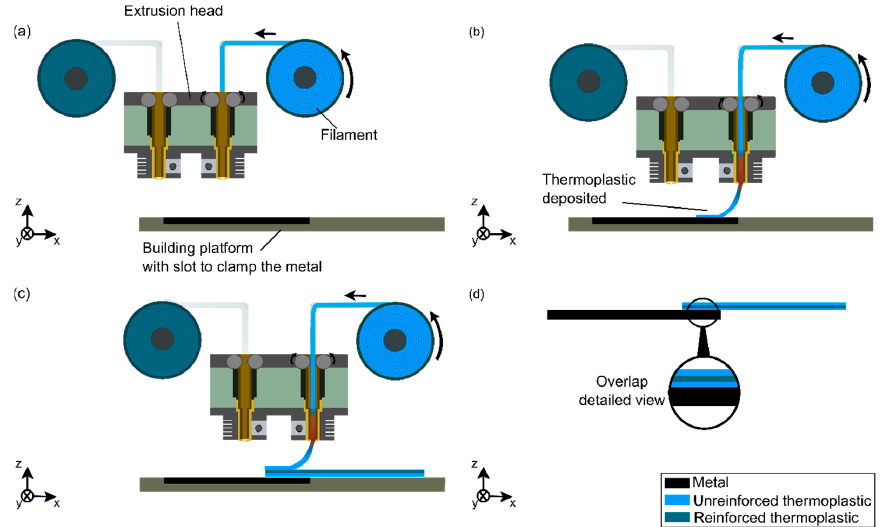
Figure 1. Schematic representation of the AddJoining process for layered metal–polymer composite hybrid structures: ( a ) initial setup, ( b ) deposition of the first polymer layer on the metal substrate, ( c ) deposition of the subsequent polymer layers, ( d ) final layered metal–polymer hybrid structure. Reprinted with permission from ref. [32]. Copyright 2022 Elsevier.